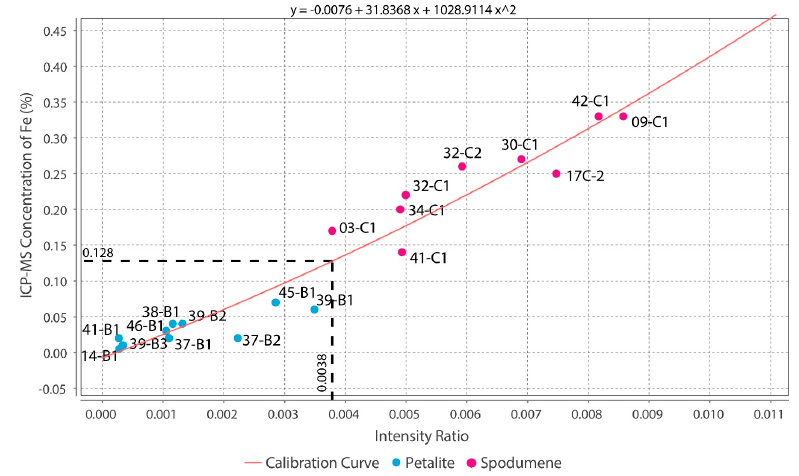
Figure 17. Successful separation of the pLIBS Fe intensity ratios for the spodumene and petalite samples of the Barroso–Alvão aplite-pegmatite fi eld.